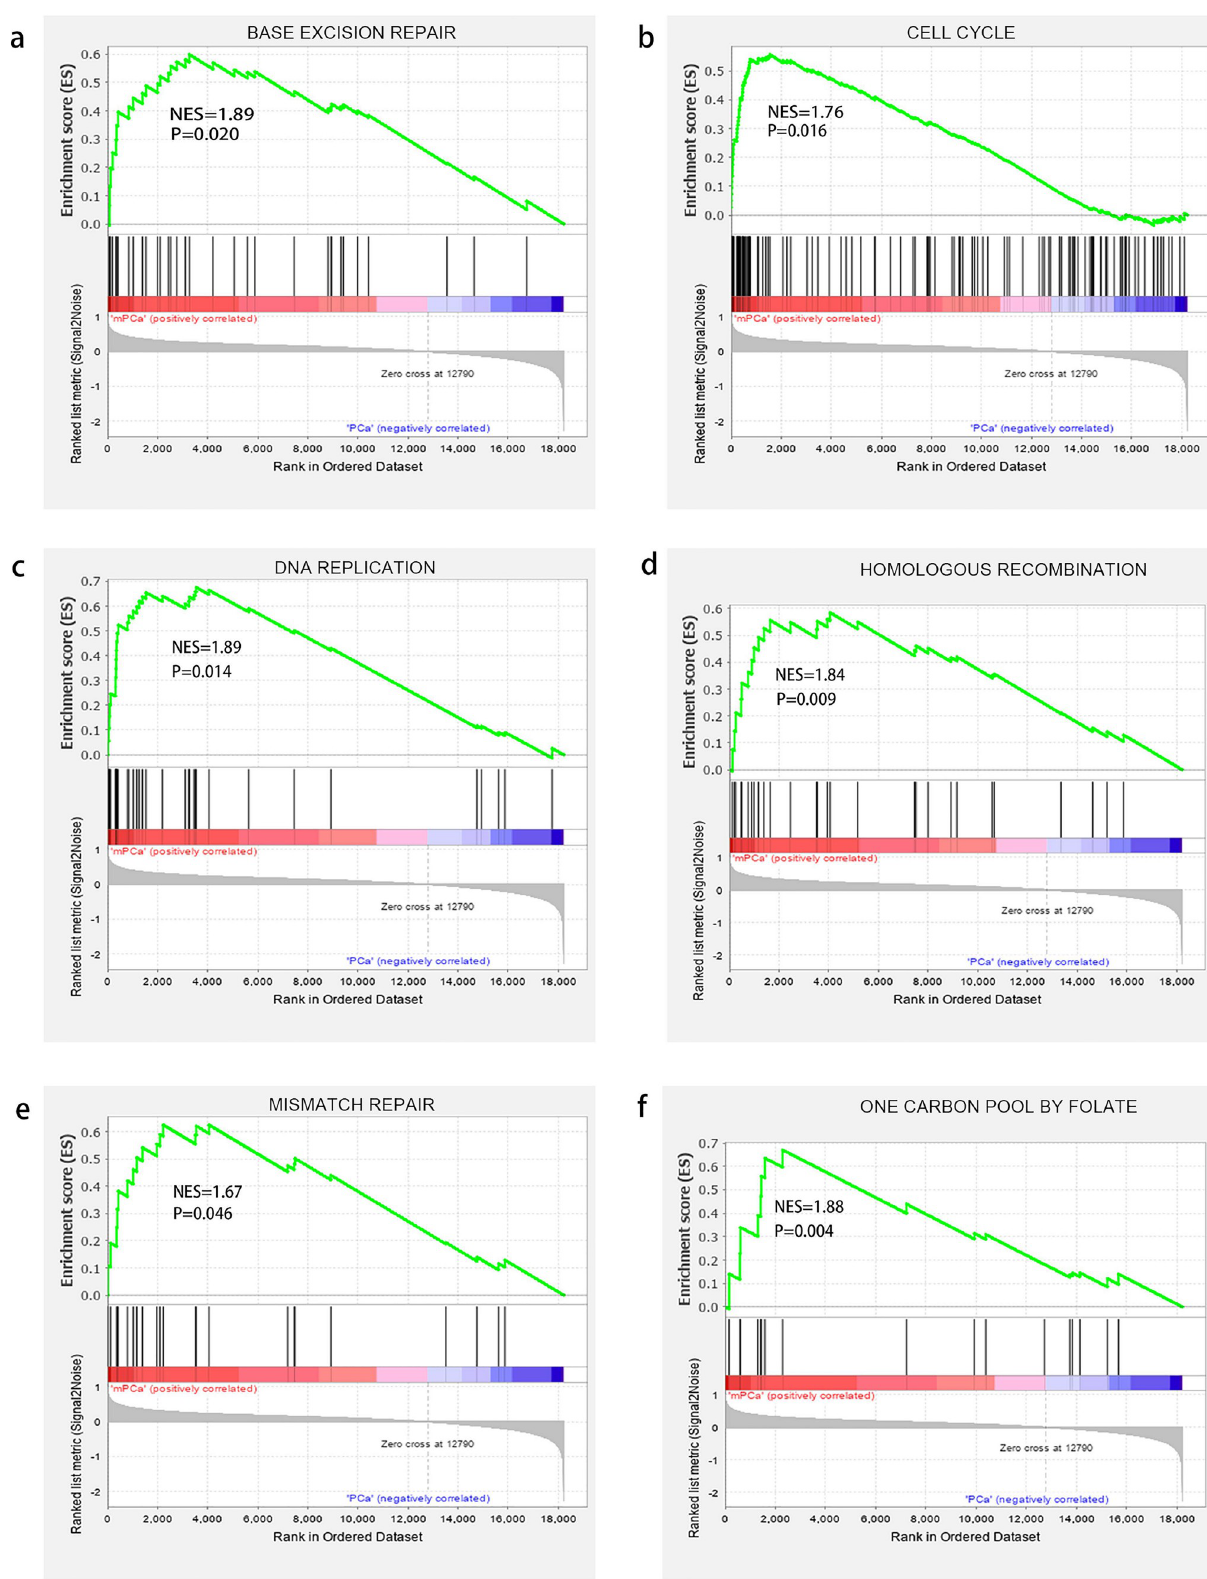
Fig 6. KEGG-GSEA was applied for the signaling pathway analysis. Pathways: A. base excision repair; B. cell cycle; C. DNA replication; D. homologous recombination; E. mismatch repair; F. one carbon pool by folate. https://doi.org/10.1371/journal.pone.0260983.g006 PLOS ONE | https://doi.org/10.1371/journal.pone.0260983 December3,